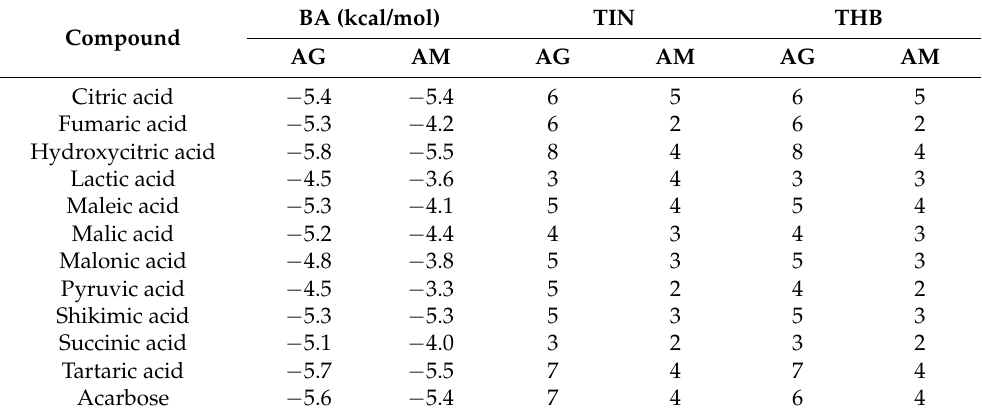
Table 10. Virtual screening of RAMULAB54 derivatives against α -glucosidase and α -amylase (PDB ID: